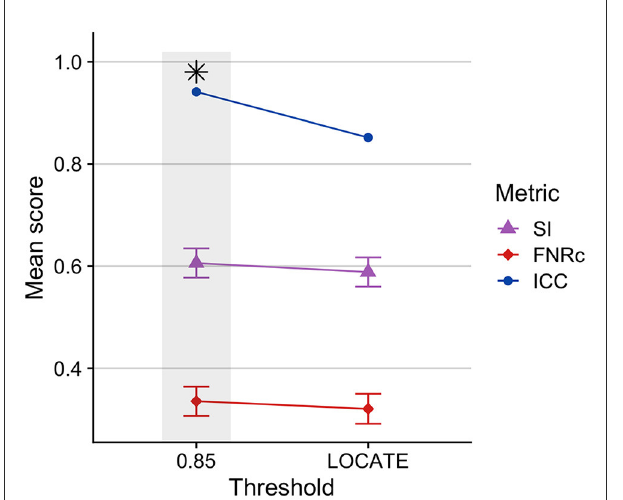
FIGURE2 Comparison of BIANCA performance on Dataset 1 training sample using a fixed threshold (0.85) compared to an adaptive threshold using LOCATE. BIANCA performed better with a fixed threshold, indicated by higher SI and ICC values. A fixed threshold of 0.85 was used in the optimized BIANCA model. Gray bars and black asterisks indicate the best-performing setting.